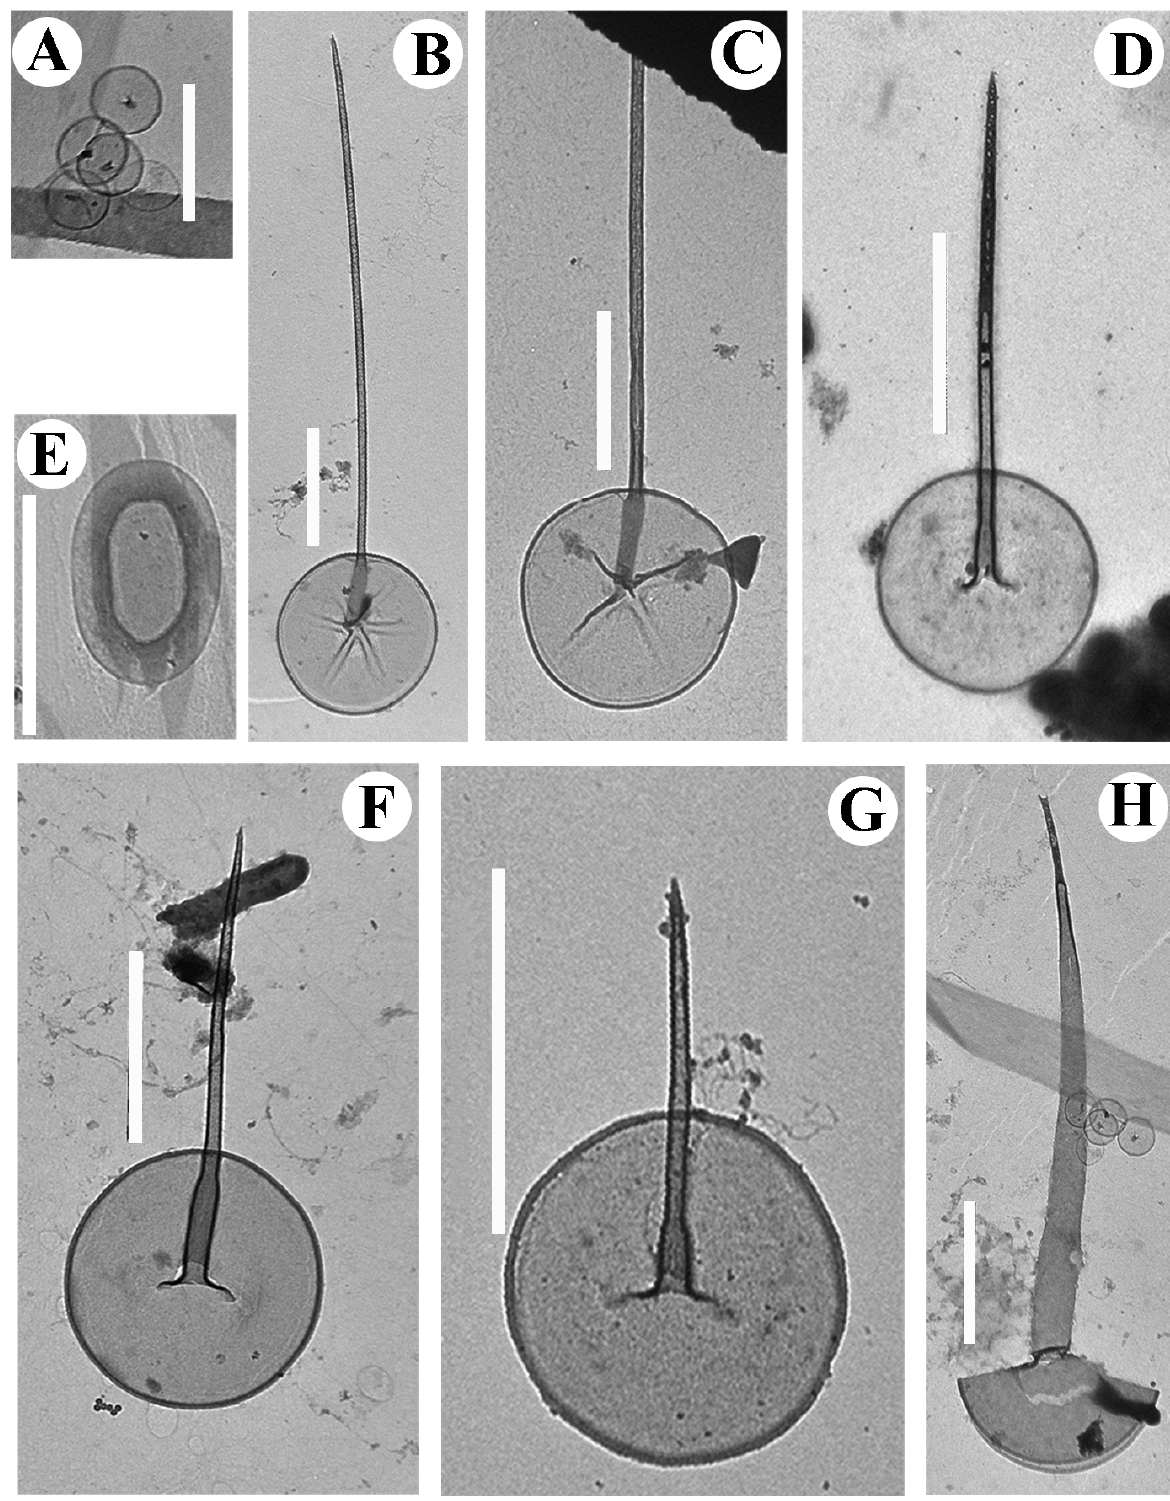
Figure 2. ( A – H ) Paraphysomonas , Spiniferomonas and Chrysosphaerella taxa from Indonesian Papua, TEM. ( A ) Paraphysomonas cf. segmenta ; ( B , C ) Paraphysomonas sp. ( D ) Paraphysomonas uniformis . ( E ) Spiniferomonas sp., a plate-like scale. ( F ) Paraphysomonas vulgaris subsp. vulgaris . ( G ) Paraphysomonas vulgaris subsp. brevispina . ( H ) Chrysosphaerella annulata , spine scale. Scale bars: ( A ): 1 µ m, ( B – H ): 2 µ